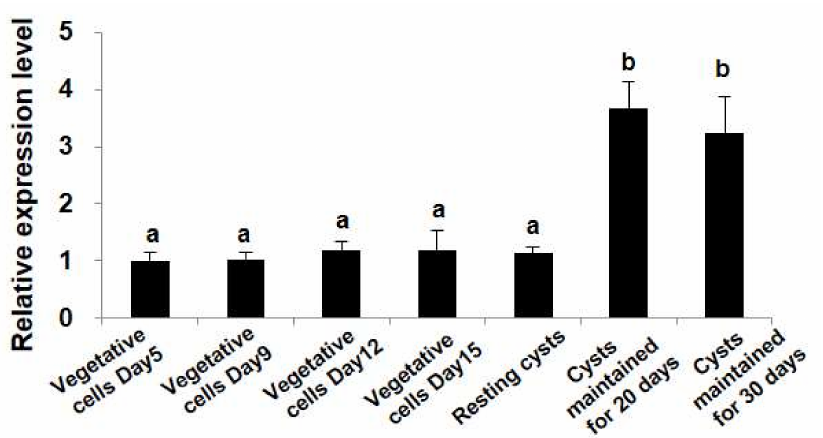
Figure 3. The transcription levels of StHsp90 in cells at different life stages (vegetative cells at the exponential and stationary growth stages, newly formed resting cysts, and resting cysts in a forced dormancy at a lower temperature and in darkness for 20 and 30 days, respectively). The relative expression values are shown as the mean fold changes compared to the control (vegetative cells collected at Day 5), with the error bars depicting the standard deviations ( n = 3). Significant differences are indicated with different letters at p <